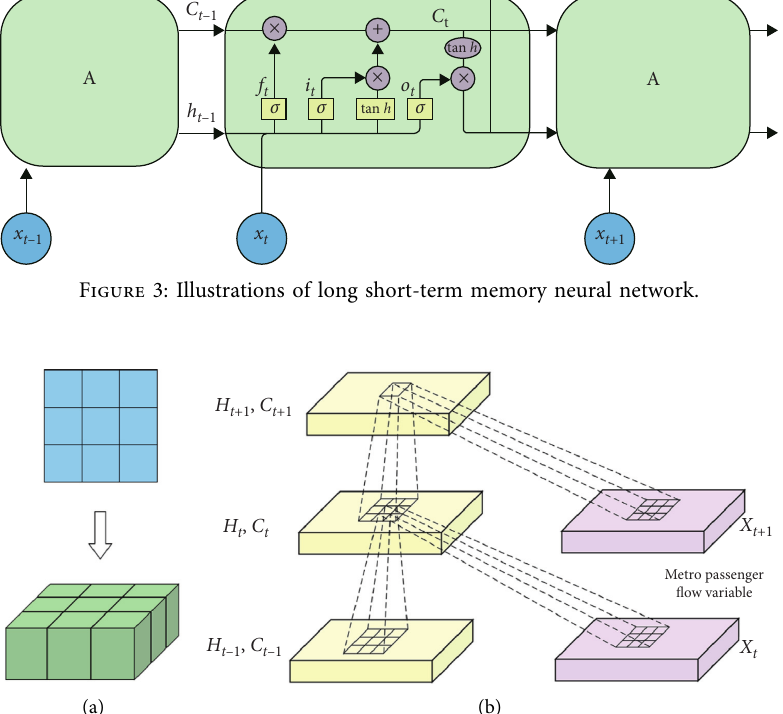
Figure 4: Illustrations of convolutional LSTM neural network. (a) The transformation from 2D matrix to 3D sensor. (b) The structure of convolutional LSTM neural